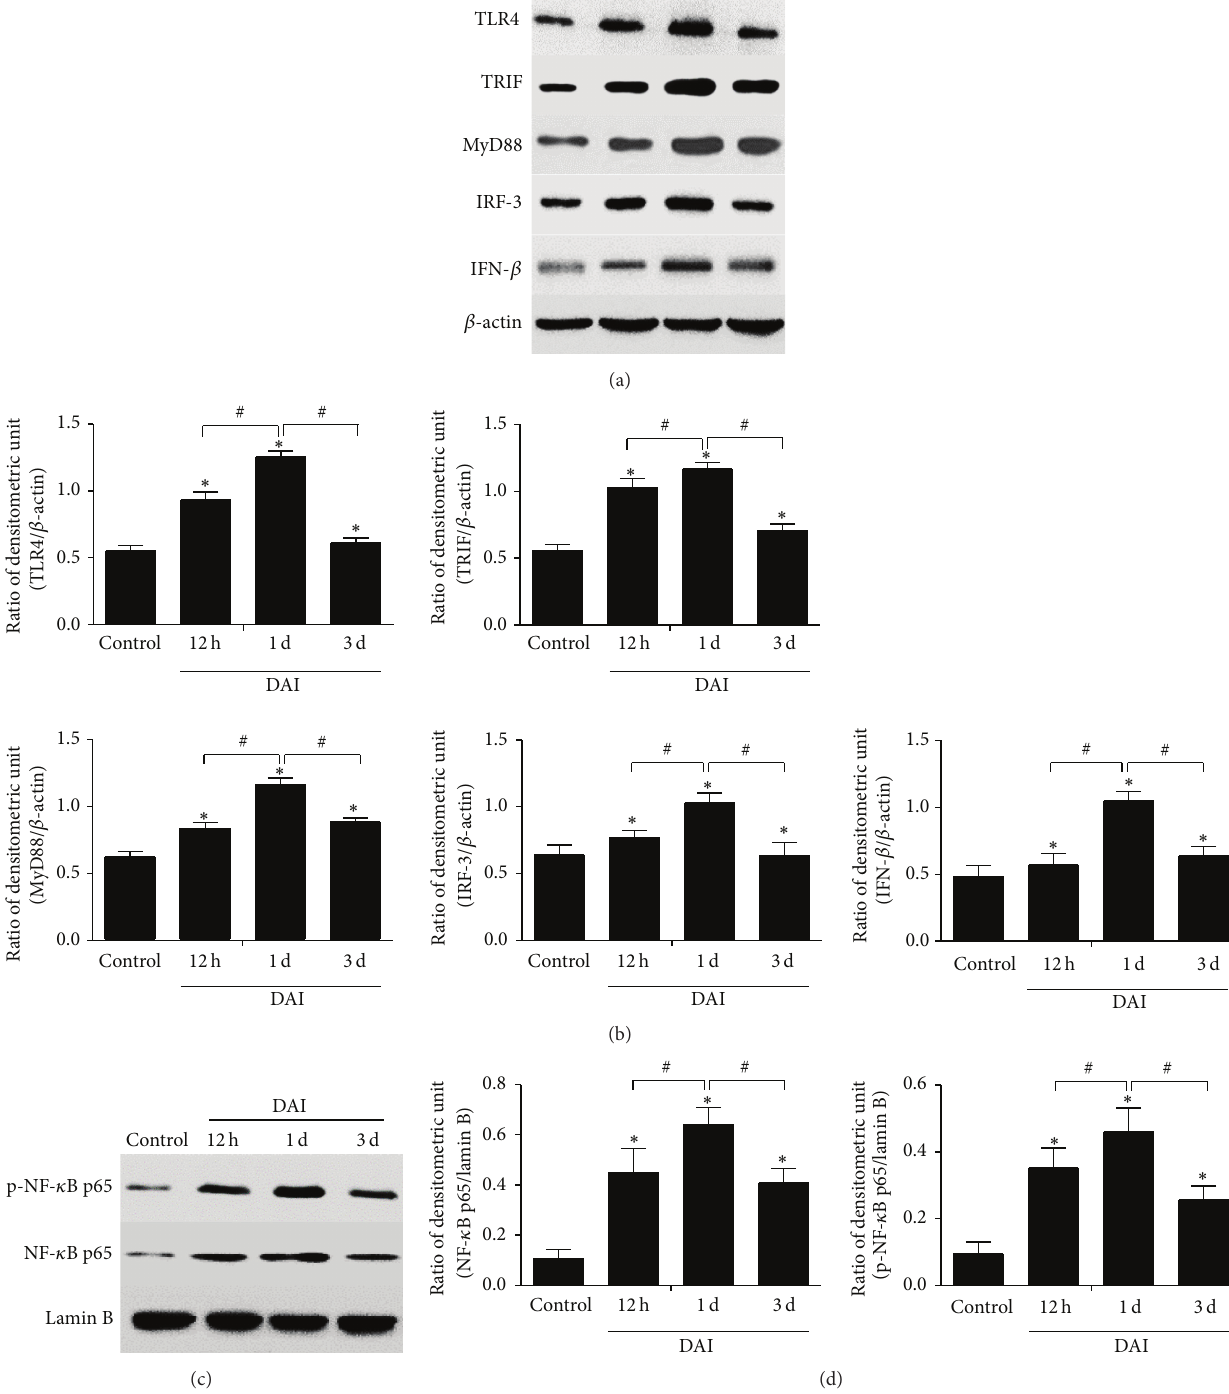
Figure 2: Dynamic expression of proteins related to the TLR4 signalling pathway after DAI. (a) Western blotting analysis was performed to measure the dynamic expression of TLR4, MyD88, TRIF, IRF3, and IFN- 𝛽 at 12h, 1d, and 3 d after DAI. (b) The bar graphs show the cortical expression results for proteins related to the TLR4 signalling pathway. The expression of 𝛽 -actin was used as an internal control. (c) Western blotting analysis was performed to measure the dynamic expression of NF- 𝜅 B and phospho-NF- 𝜅 B expression in nuclear extract at 12h, 1d, and 3 d after DAI. (d) The bar graphs show the results for NF- 𝜅 B and phospho-NF- 𝜅 B expression in the nuclear extract. The expression of lamin B was used as an internal control. Values are presented as the mean ± SD ( 𝑛 = 6 ; ∗ 𝑝 < 0.05 , compared with control group; # 𝑝 < 0.05 , compared with DAI 1 d